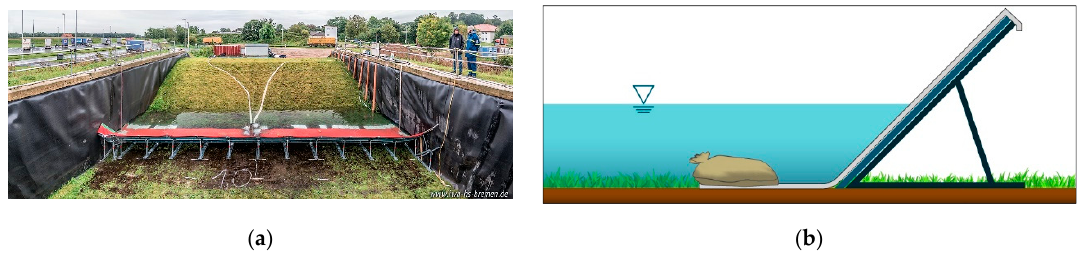
Figure 6. Trestle system tested in the IWA test facility, ( a ) aqua defense (non-filled), ( b ) schematic diagram of the aqua defense system.